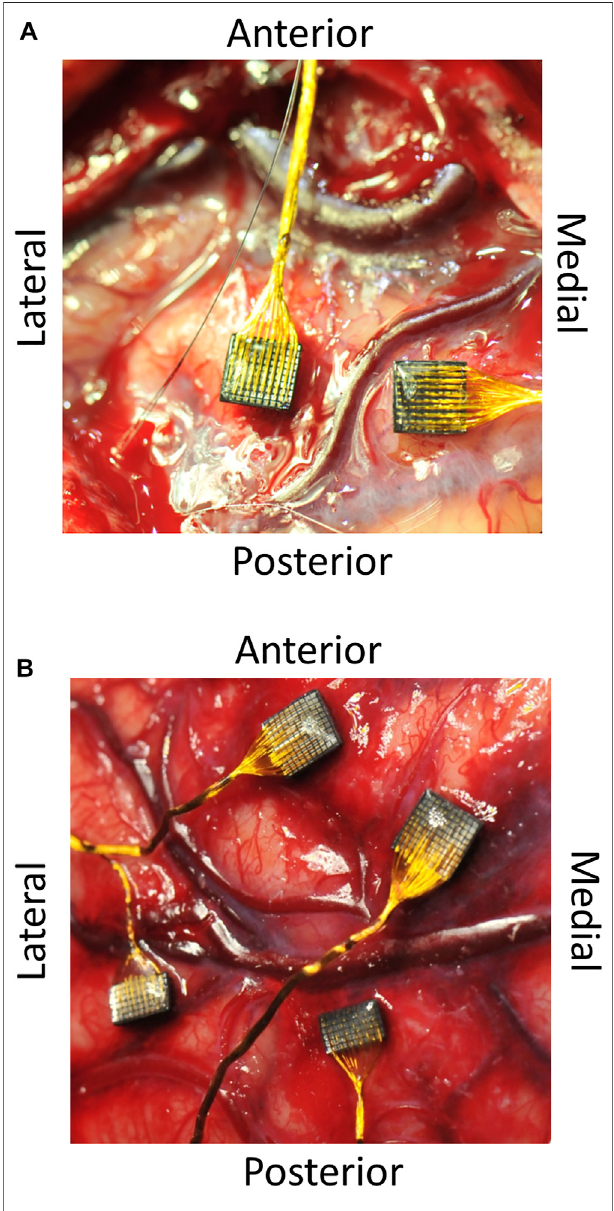
FIGURE 1 | Six electrode arrays were implanted in two participants: two recording arrays in P1 motor cortex, two recording arrays in P2 somatosensory cortex, and two stimulating arrays in P2 parietal cortex. Intraoperative images of implanted arrays in P1 (A) and P2 (B) . The image taken in (A) is before implantation of the electrodes, and (B) is after implantation. Reference wires can also be seen in (A) near the arrays.